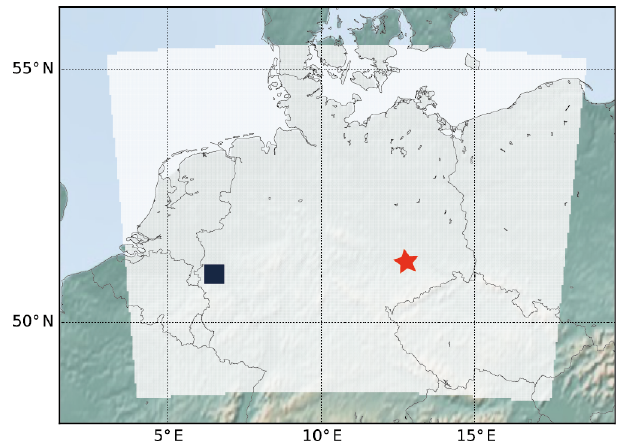
Figure 1. Model domain over Germany that was used in this study (white area). The red star marks the research station Melpitz (51.53 ◦ N, 12.93 ◦ E), and the black square marks the measurement site Jülich (50.88 ◦ N, 6.41 ◦